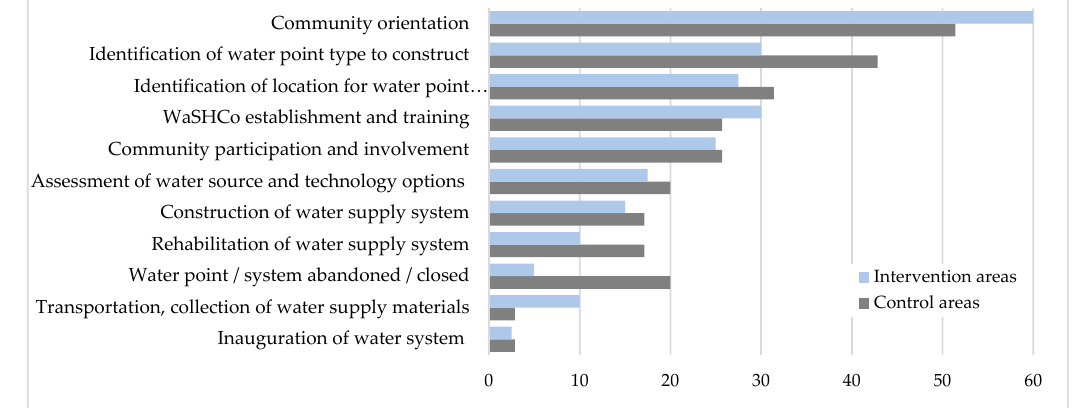
Figure 6. Activities linked to water according to WaSH committees.